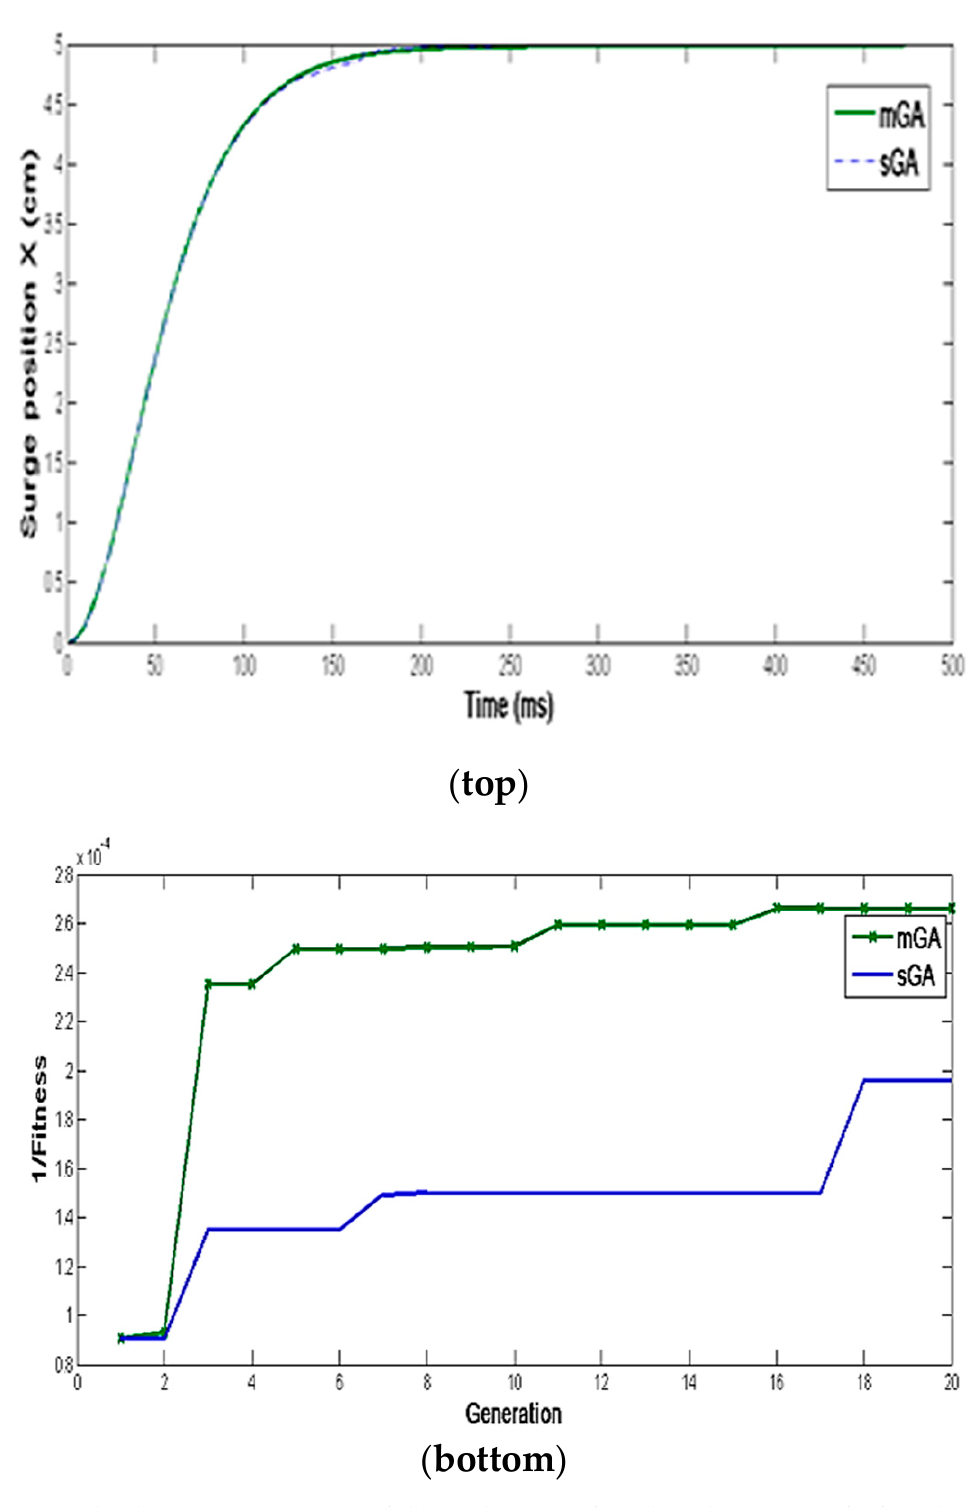
( top ) ( bottom ) Figure 6. ( Top ) Sway—position control; ( bottom ) improved GA (mGA) versus standard GA (sGA) fitness functions.